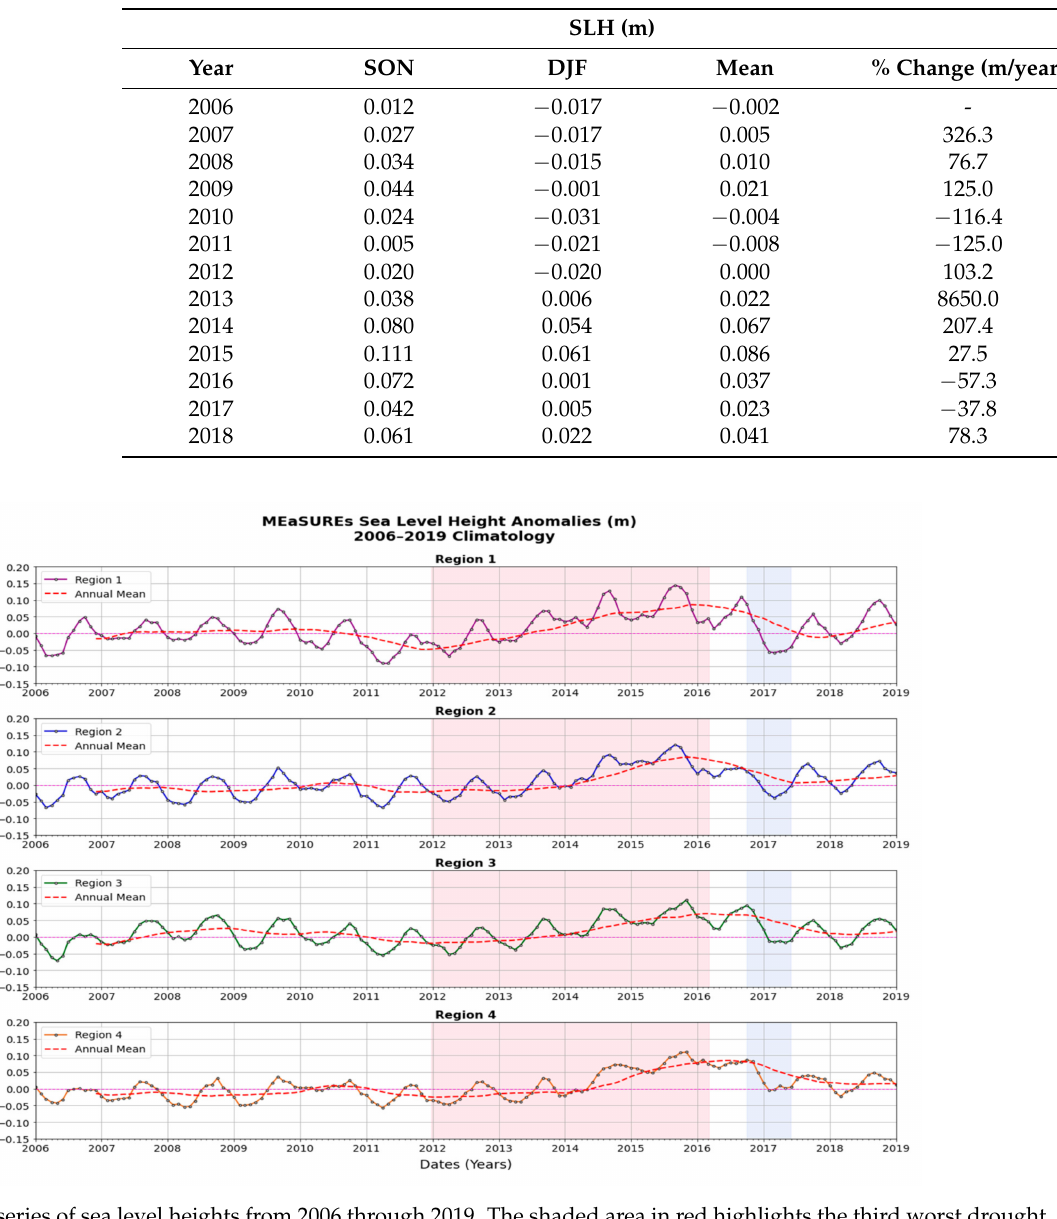
Figure 8. Time series of sea level heights from 2006 through 2019. The shaded area in red highlights the third worst drought, while the extreme rain season is shaded in